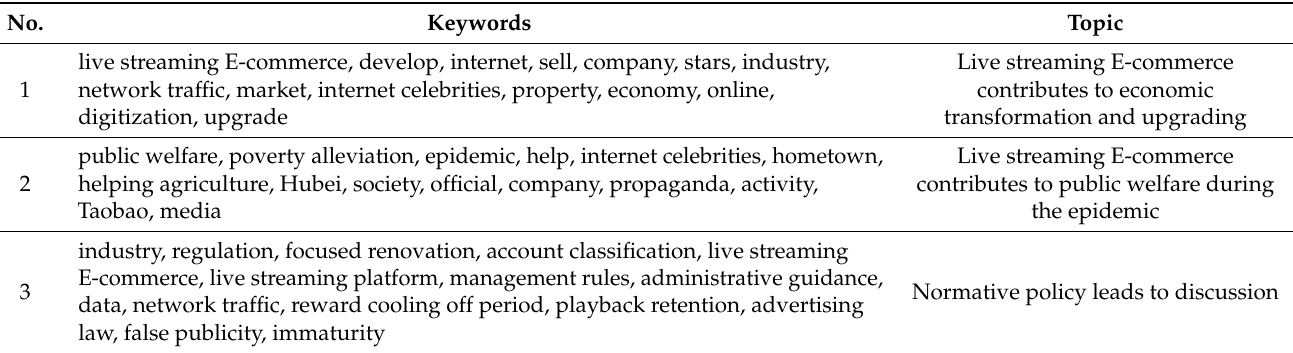
Table 9. Online HDP models after policy